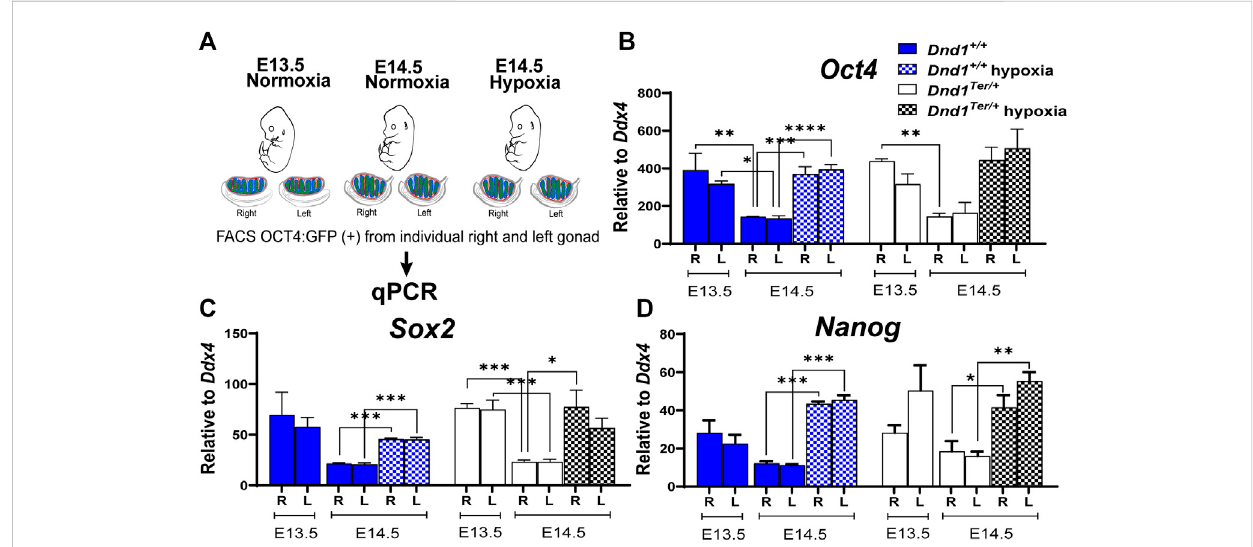
FIGURE 3 Hypoxia promotes the expression of the core pluripotency genes in germ cells in vivo . (A) Schematic representation of the experimental design. Pregnant females were exposed to hypoxia between E13.8 and E14.3. The hypoxic right (R) and left (L) gonads, toguether with normoxic controls, were disected at E13.5 and E14.5. The OCT4:GFP(+) cells were sorted by FACS and total RNA was extracted to perform qPCR evaluating the expression of (B) Oct4 ( Dnd1 +/+ and Dnd1 Ter/+ E13.5 and E14.5 n = 3; Dnd1 +/+ and Dnd1 Ter/+ hypoxia n = 5) (C) Sox2 ( Dnd1 +/+ and Dnd1 Ter/+ E13.5 and E14.5 n = 3; Dnd1 +/+ and Dnd1 Ter/+ hypoxia n = 3) and (D) Nanog ( Dnd1 +/+ and Dnd1 Ter/+ E13.5 and E14.5 n = 3; Dnd1 +/+ and Dnd1 Ter/+ hypoxia n = 3). Gene expression was normalized to Ddx4 . Statistical signi fi cance between the gene expression in germ cells from the right or left gonads at different ebryonic stage or oxygen levels were determined using one way ANOVA multicomparison test with Tukey ’ s correction. p -values are represented by asterisk where *: p < 0.05, **: p < 0.01, ***: p < 0.001, and ****: p <